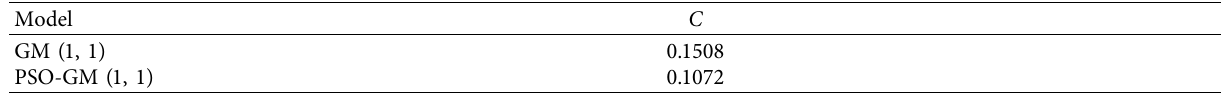
Table 11: Accuracy assessment